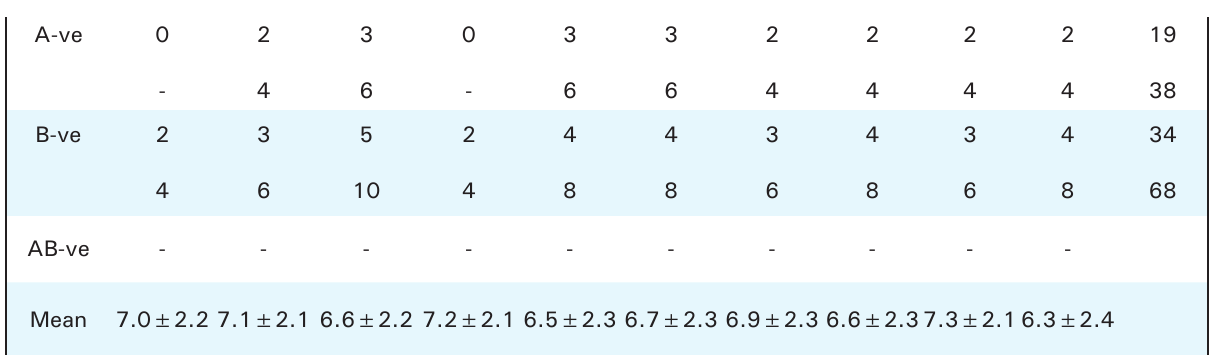
Mean P 0.68 The maximum number of whorls was seen in right ring finger of O+ve blood group. The percentagewise whorl distribution was highest in right index, left thumb and left ring fingers of AB+ve blood group. There was